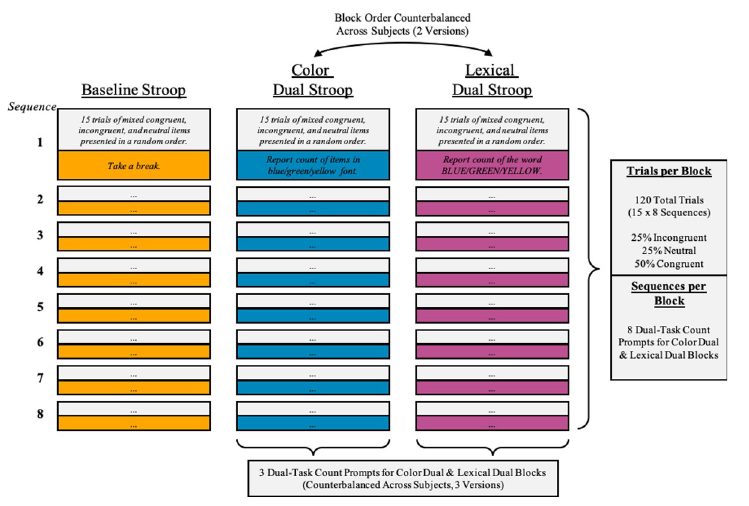
Fig 1. Experimental design